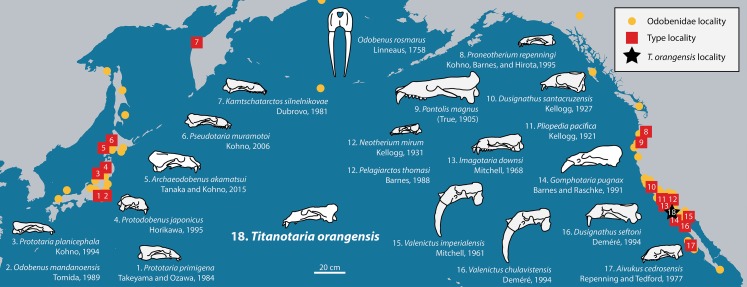
Distribution of fossil odobenid localities in the Pacific.Circles represent published localities. Numbered squares represent type localities. A star represents the locality of Titanotaria orangensis (OCPC 11141). Figured skulls are known from complete or partial cranial material and are drawn to scale referencing line drawings by Robert W. Boessenecker. The specimens facing right are found in the Western Pacific, while specimens facing left are found in the Eastern Pacific. Occurrence data and basemap were obtained from the Paleobiology Database using the following parameters: family = Odobenidae. Major contributors to this data set were John Alroy and Mark Uhen.